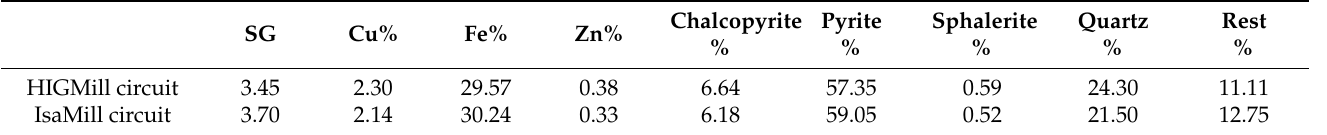
Table 6. Specific gravities (SG), head assays and mineral distributions of the circuit feed sample.